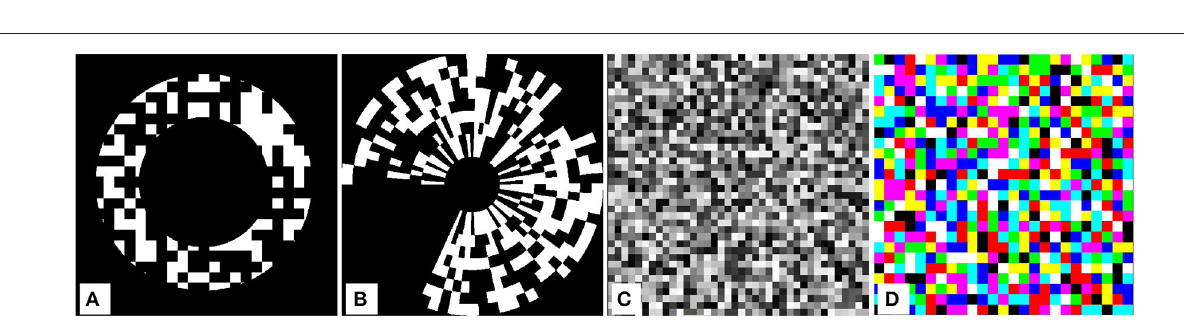
FIGURE 8 | Random checkerboard stimuli. Binary (black and white) figures are colored depending on whether the magnitude of the random numbers, spread within [0 ... 1], is greater or less than 0.5. Gray shades are generated by linear mapping of random numbers to the dynamic range. Colored checkerboards are generated using three sets of random numbers, for the red, green and blue channels. (A) Binary, restricted to annulus. (B) Binary, in polar coordinates. (C) Grayscale. (D) Color.